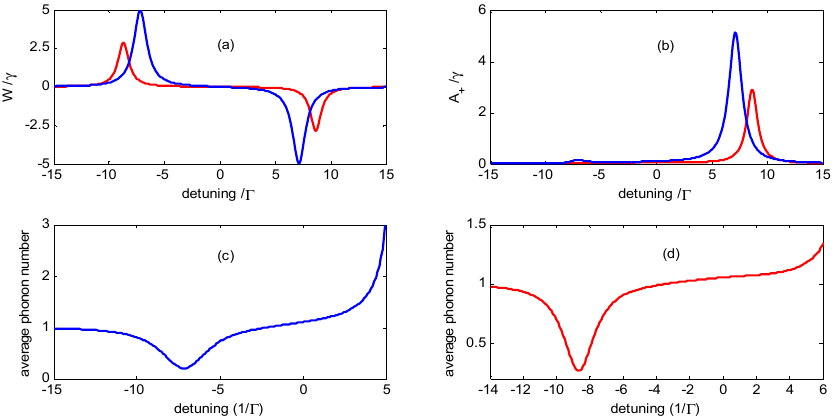
Figure 2. ( a ) the rate W/ γ as a function of the driving detuning ∆ = ω d − ε for di ff erent driving Rabi Figure 2. ( a ) the rate W/γ as a function of the driving detuning Δ = 𝜔 (cid:3031) − 𝜀 for different driving Rabi frequencies Ω 0 = 5 Γ (red line) and Ω 0 = 7 Γ (blue line); ( b ) A + / γ as a function of the driving detuning frequencies Ω (cid:2868) = 5𝛤 (red line) and Ω (cid:2868) = 7𝛤 (blue line); ( b ) 𝐴 (cid:2878) /𝛾 as a function of the driving ∆ for di ff erent driving Rabi frequencies Ω = 5 Γ (red line) and Ω = 7 Γ (blue line); ( c ) the average detuning Δ for different driving Rabi frequencies Ω (cid:2868) = 5𝛤 (red line) and Ω (cid:2868) = 7𝛤 (blue line); ( c ) 0 0 photon number of the cavity as a function of the driving detuning ∆ for Ω 0 = 7 Γ ; ( d ) the average photon the average photon number of the cavity as a function of the driving detuning Δ for Ω (cid:2868) = 7𝛤 ; ( d ) the number of the cavity as a function of the driving detuning ∆ for di ff erent driving Rabi frequencies, average photon number of the cavity as a function of the driving detuning Δ for different driving Ω = 5 Γ (red line). γ = 0.02, n = 1, Γ = Γ r = Γ = 1, ω m = 10 Γ , η = 0 l Rabi frequencies, Ω (cid:2868) = 5𝛤 (red line). γ = 0.02 , 𝑛(cid:3364) = 1 , Γ (cid:3039) = 𝛤 (cid:3045) = Γ = 1 , 𝜔 (cid:3040) = 10Γ , η = 0.05 .